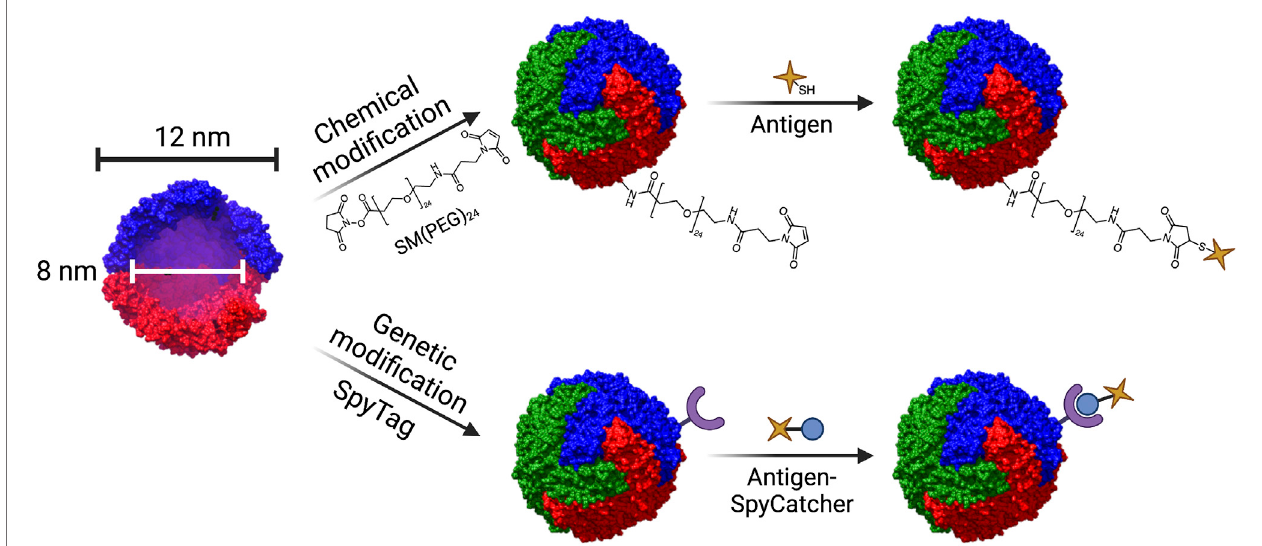
FIGURE 9 | Structure of the ferritin nanocage and techniques used for conjugation of antigen. Ferritin nanocages have an outer diameter of 12 nm, and a hollow inner core of 8 nm in diameter. Ferritin can be modi fi ed in a variety of ways to conjugate antigen. Chemical modi fi cation involving heterobifunctional linkers such SM(PEG) 24 enable conjugation of antigen via click chemistry (top). Genetic modi fi cation can enable conjugation of antigen through the SpyTag/SpyCatcher system (bottom). The crystal structure of L-ferritin (pdb id. 2fg8 (Wang et al., 2006)) was used to model the ferritin nanocage. The nanocage was constructed using UCSF Chimera, developed by the Resource for Biocomputing, Visualization, and Informatics at the University of California, San Francisco, with support from NIH P41- GM103311 (Pettersen et al.,